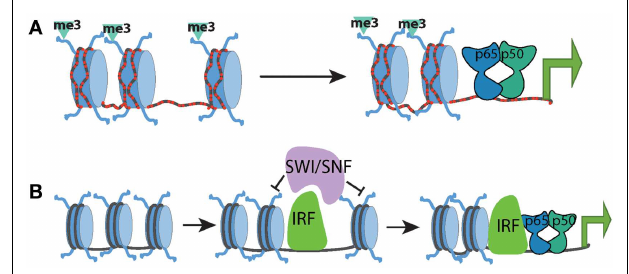
FIGURE 1 | Chromatin state at different promoter classes dictates the kinetics of the NF-kB response . (A) CpG-island promoters (red dashed lines) are characterized by high levels of histone H3K4me3 and more highly accessible chromatin.This allows for rapid transcriptional induction by NF-kB, independent of the need for any SWI/SNF-dependent nucleosome remodeling. (B) Low-CpG promoters contain inactive and inaccessible chromatin signatures in the basal state, which forms a barrier to NF-kB binding and transcriptional activation. SWI/SNF complexes must be recruited to these genes by additional factors such as IRF proteins in order to facilitate chromatin remodeling. Upon chromatin remodeling, NF-kB can bind and induce